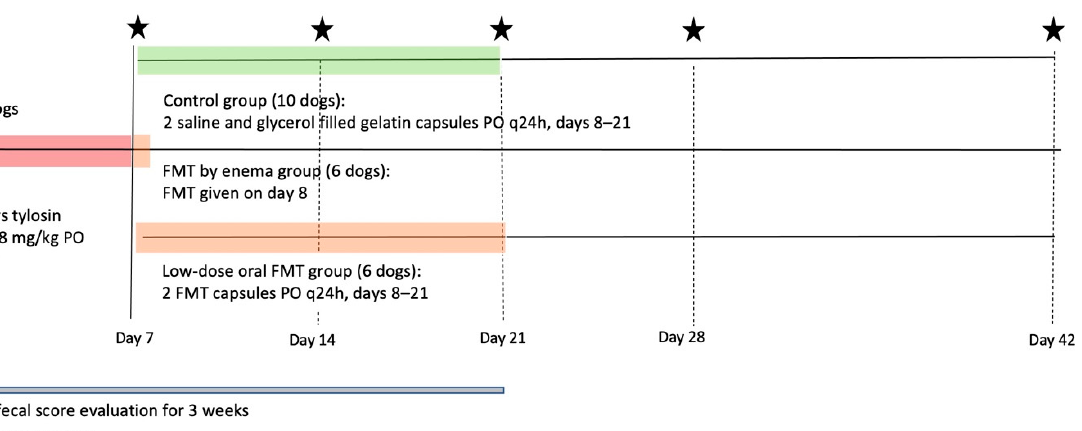
Figure 1. Schematic illustrating study intervention, duration, observations, and sampling. Legend: FMT; fecal microbiota